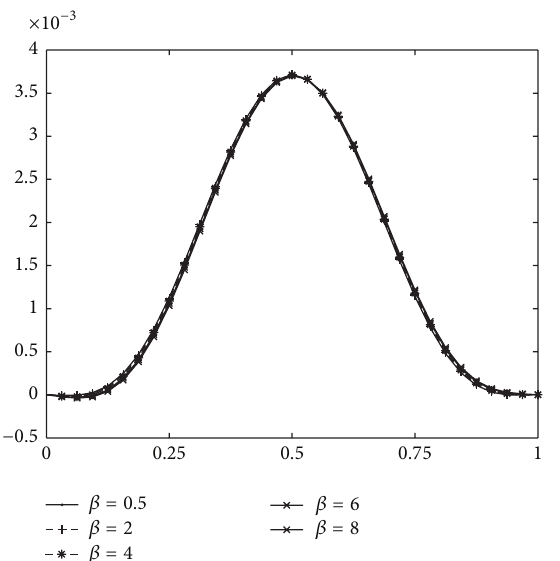
Figure 13: Absolute error distribution at ℎ = 1/32 , 𝜏 = 0.1 , 𝛽 = 1 , 𝛼 = 2 , 𝑝 = 4 , and 𝑡 = 10